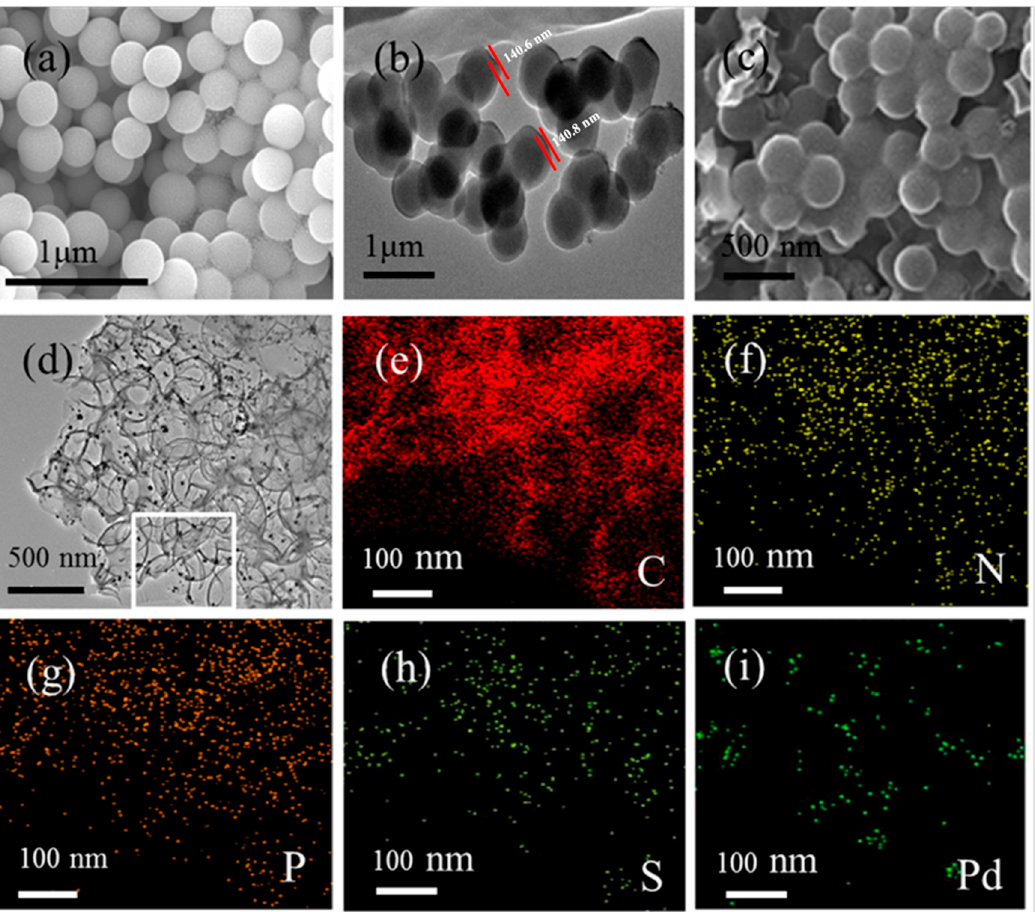
Figure 1. Scanning electron microscope (SEM) images of ( a ) SiO 2 , transmission electron microscope (TEM) image of ( b ) PCCP@SiO 2 , ( c ) SEM image of C–N,P,S, ( d ) TEM image of Pd/C–N,P,S and electrospray ionization (EDS) elemental mapping of ( e – i ) C, N, P, S, and Pd elements for Pd/C–N,P,S catalysts.